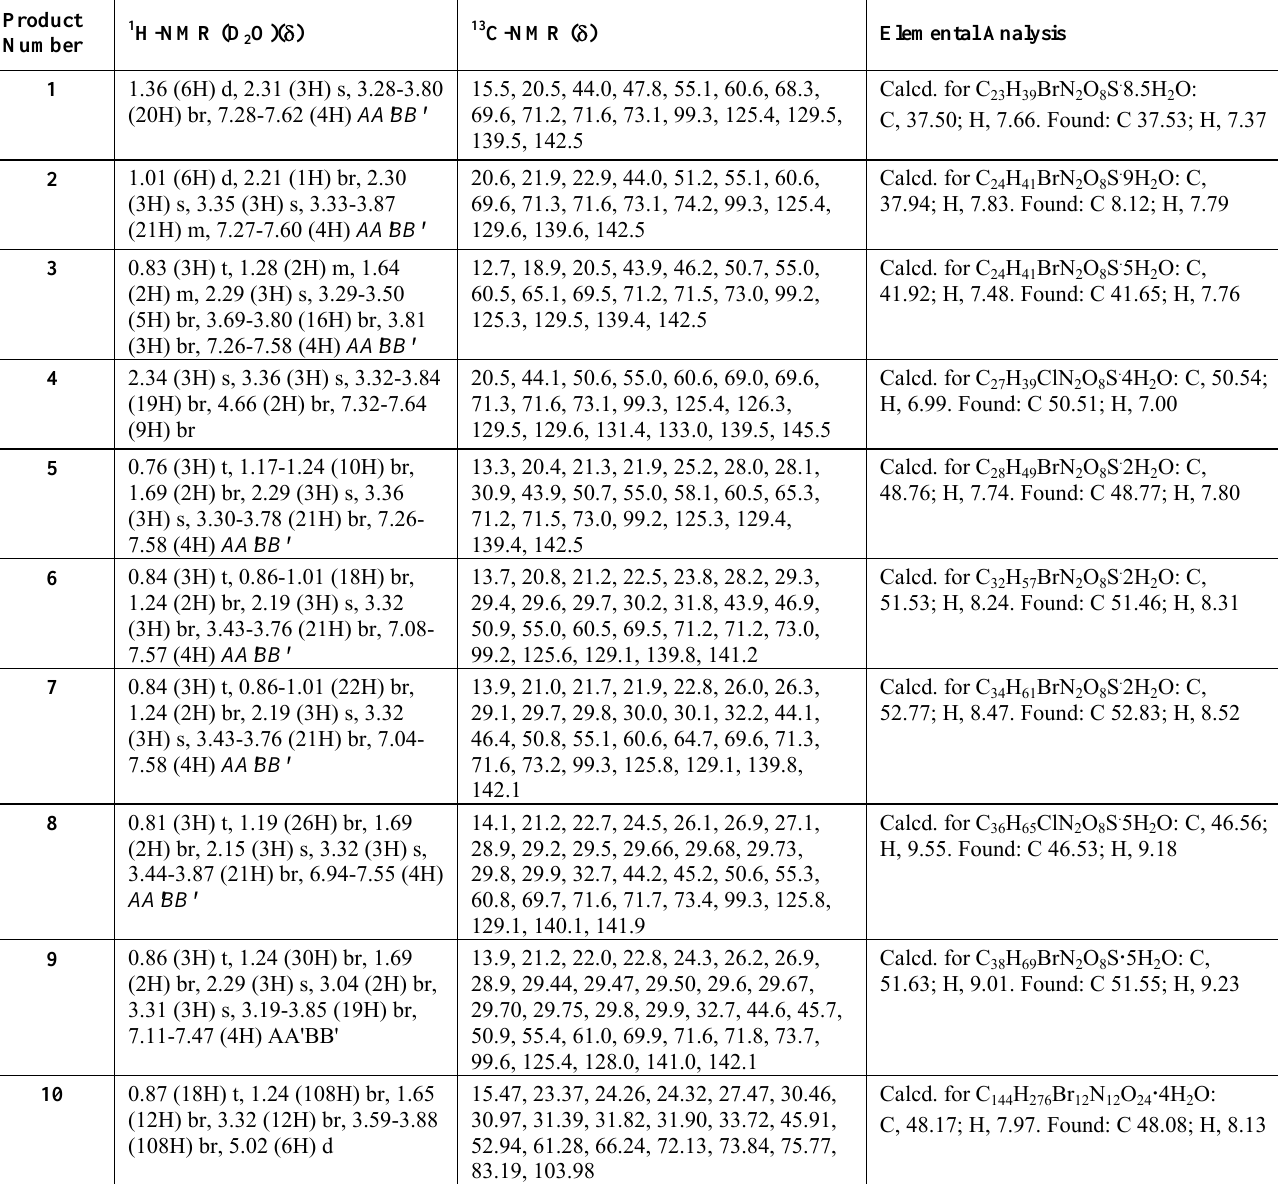
Table 2. Structural verification data for cationic